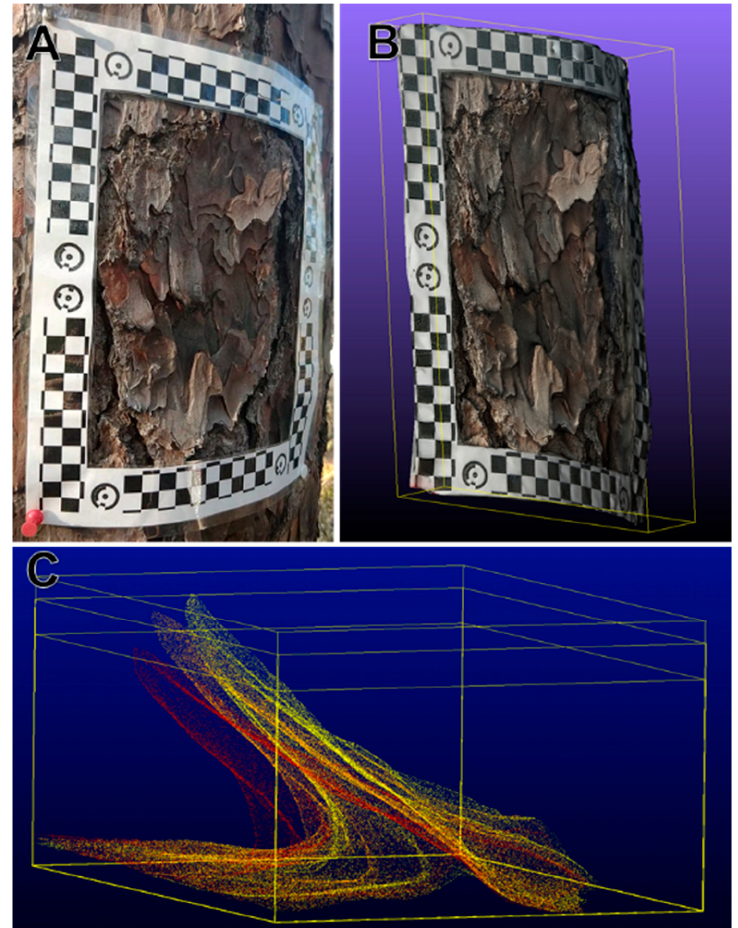
Figure 1. ( A ) Many individual images of longleaf bark inside a custom scaling frame were processed in photogrammetry software to produce a ( B ) three-dimensional model that can be sampled and analyzed. ( C ) A single bark flake cropped from a model tracked through a single day, red at 0800, orange at 1100, and yellow at 1400. The bounding box heights represent the bark flake apex distances from the bark surface that peels away through each time